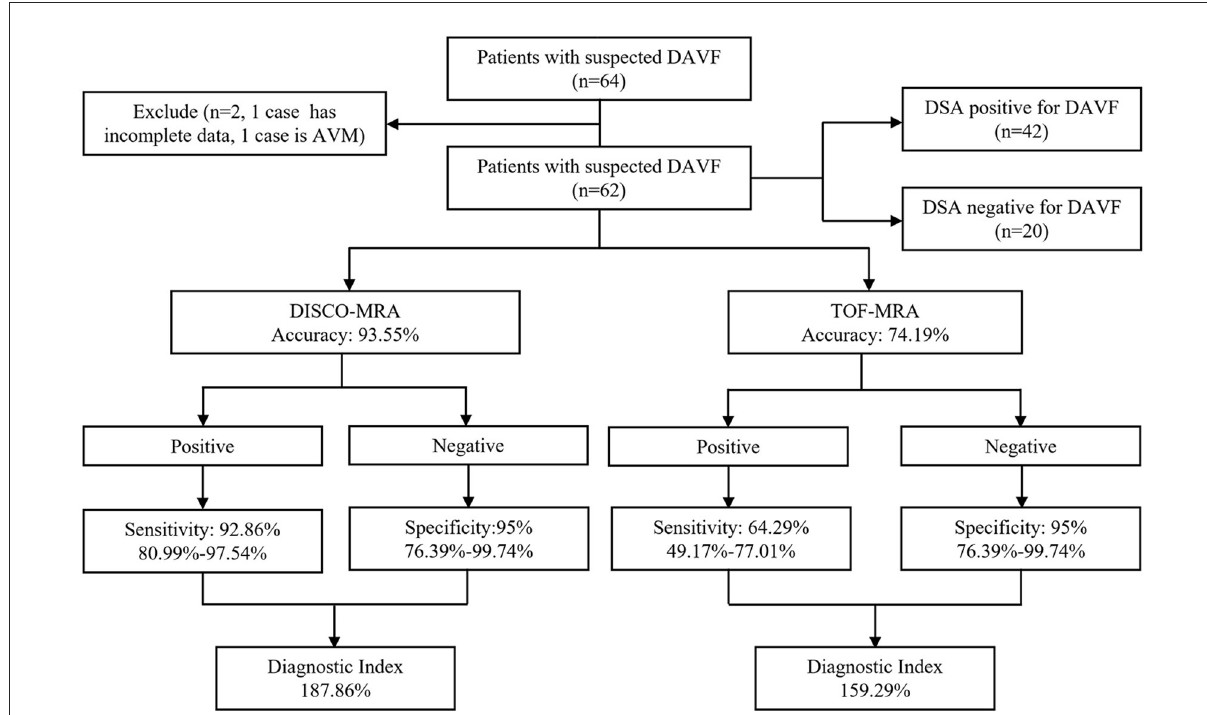
FIGURE2 Organizational chart illustrating the patient makeup of this study. The chart includes the accuracy, sensitivity, specificity and diagnostic index (mean with or without 95% confidence interval) of each sequence for detecting DAVF.